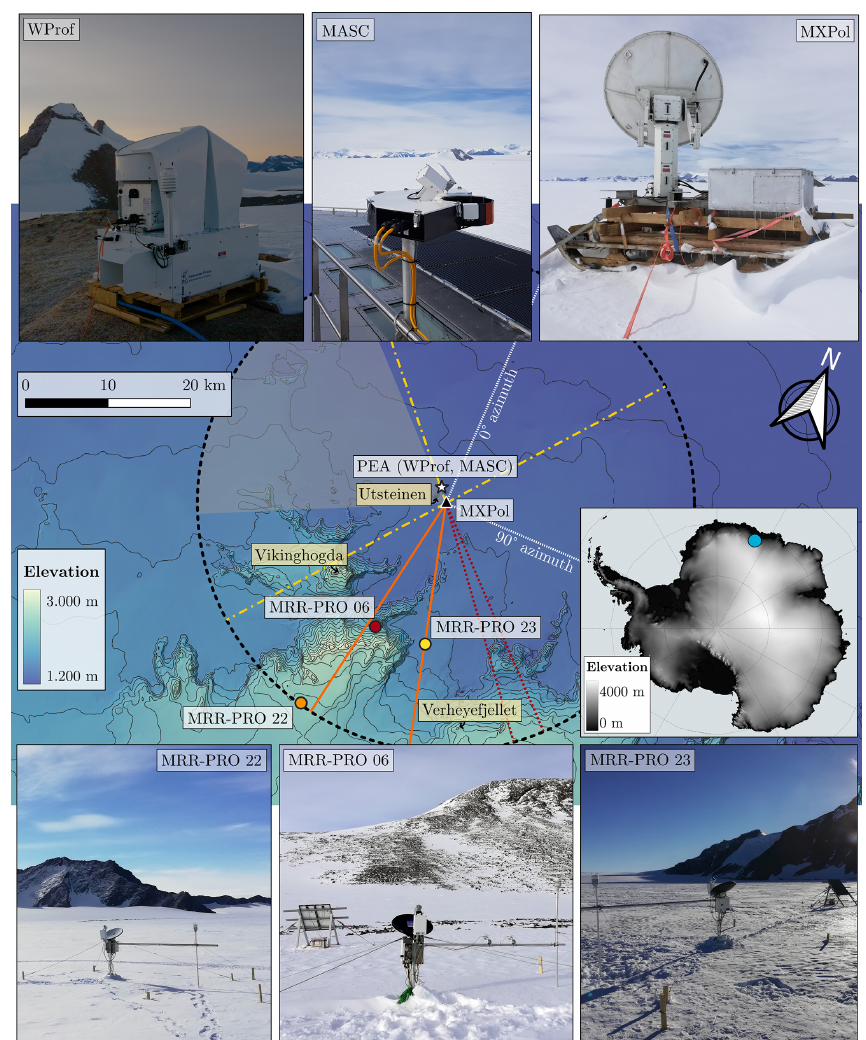
Figure 1. Elevation map of the region surrounding PEA. The markers and the accompanying text on the white background superimposed to the map highlights the location of the instruments deployed during the campaign. The mountain peaks mentioned in the paper are denoted by text on a pale yellow background. A picture of each of them is provided in the six panels above and below the map. The dashed black circle shows the maximum detectability radius of X-band dual-polarization Doppler scanning weather radar (MXPol), while the colored radii illustrate the direction of the range–height indicator (RHI) scans: the dashed–dotted yellow lines show the scan belonging only to the first cycle, the dotted red ones belong only to the second cycle, and the continuous orange ones belong to both. The shaded gray area shows the range of azimuth angles excluded from the plan position indicator (PPI) scans. The small panel on the righthand side of the figure shows the position of PEA on the Antarctic continent. In both panels, the elevation has been derived from the Reference Elevation Model of Antarctica (REMA) digital elevation model (Howat et al.,